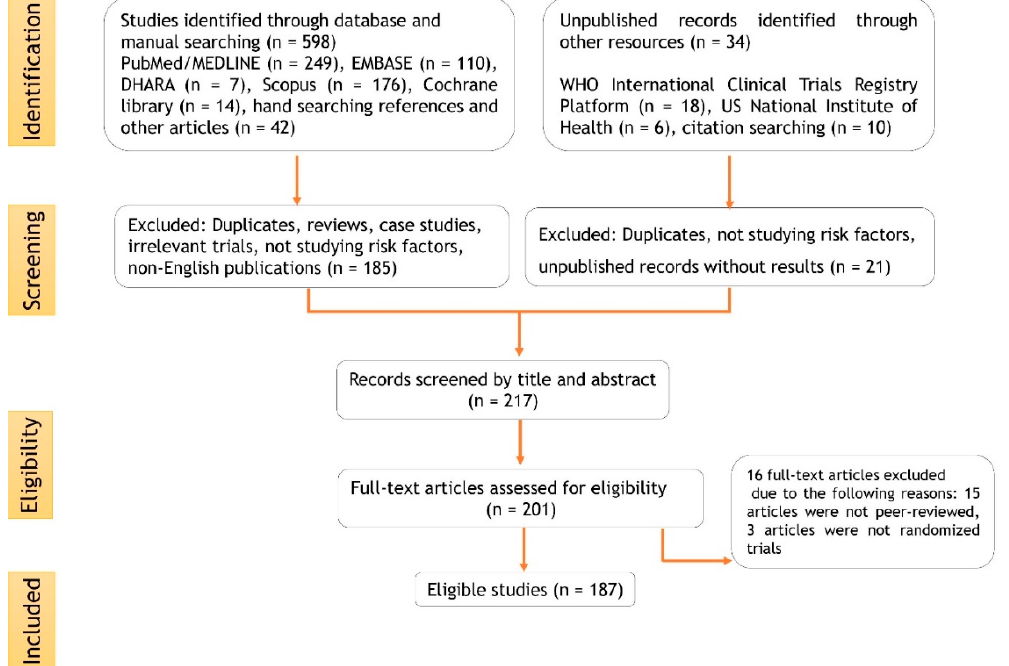
Figure 3. Flowchart of the selection process.